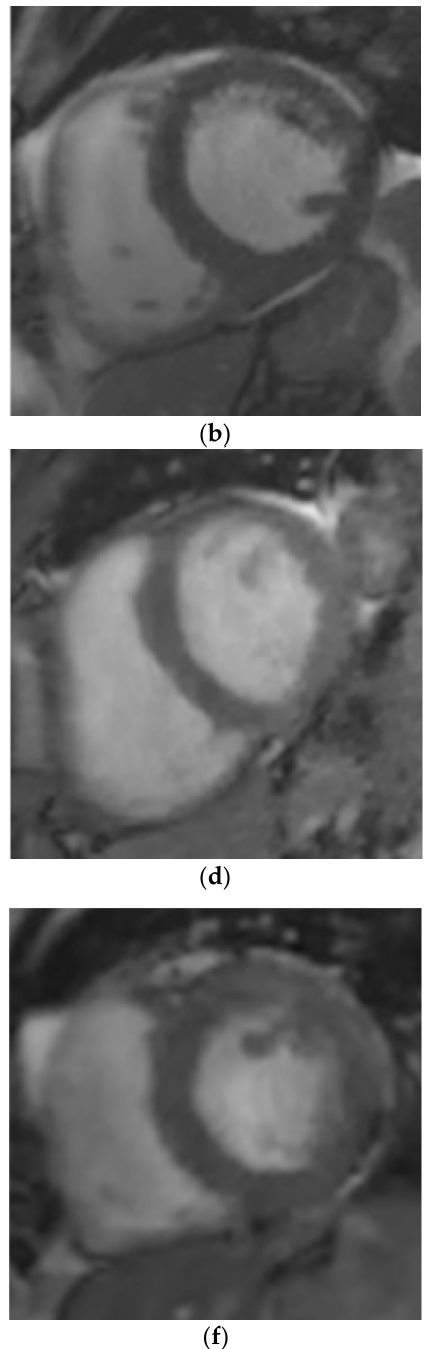
Figure 2. Examples of comparisons between Cine ref and CS rt sequences in three patients suffering from arrhythmia. Mid-